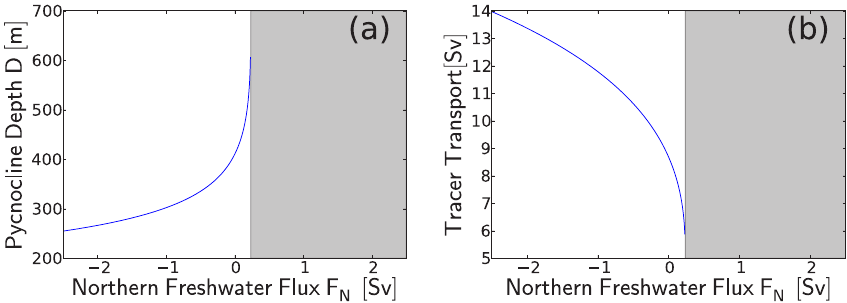
Figure 4. In steady state the governing equation for the mixing-driven case has one real, stable solution (a) until a threshold level is reached (grey shaded area). Thereafter, no real solution exists. The tracer transports are upwelling in the mid latitudes and northern sinking which balance each other ( m N = m U ) and decrease under increasing freshwater forcing (b)